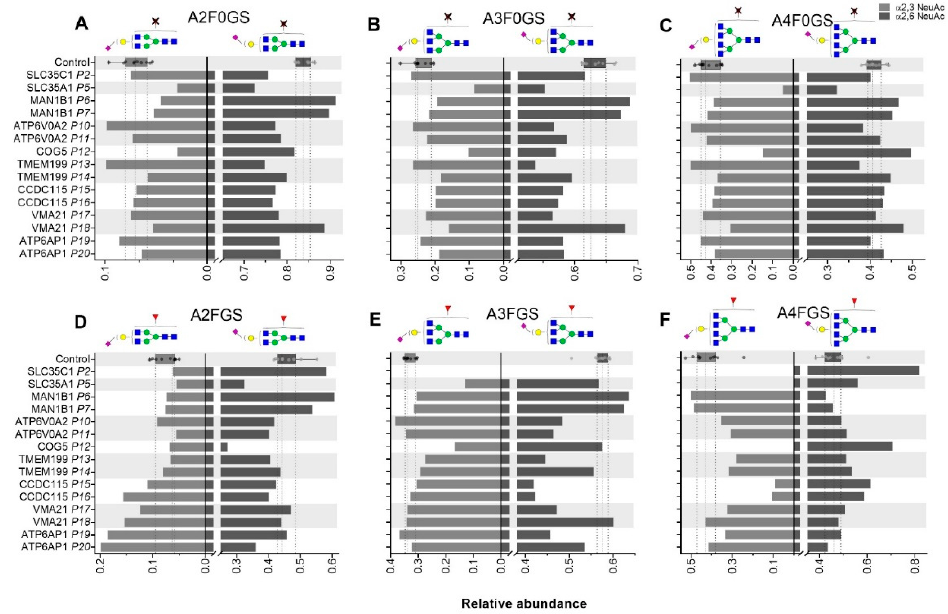
Figure 4. Total plasma N -glycome (TPNG) structural features determined for CDG patients. Levels of α 2,3-sialylation per galactose (left) and α 2,6-linked sialylation per galactose (right) are displayed for non-fucosylated ( A ) diantennary, ( B ) triantennary and ( C ) tetraantennary glycans as well as for fucosylated ( D ) diantennary, ( E ) triantennary and ( F ) tetraantennary glycans. The box plot shows the median (dashed line) with the interquartile range (dotted lines) for healthy controls ( n = 10) whilst the bars give the individual values determined for the CDG patients.